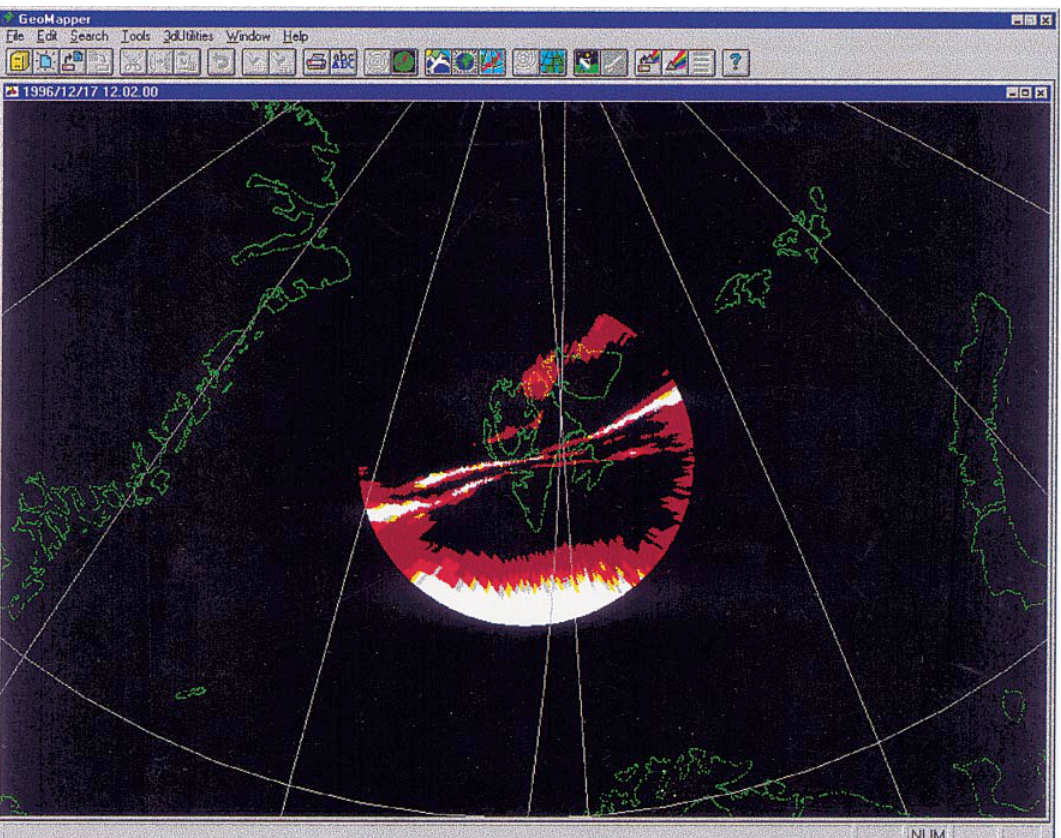
of the NNSS satellite pass crossing 75 (cid:176) N at 12:06 UT, is indicated by the line running from northeast to southwest on the figure